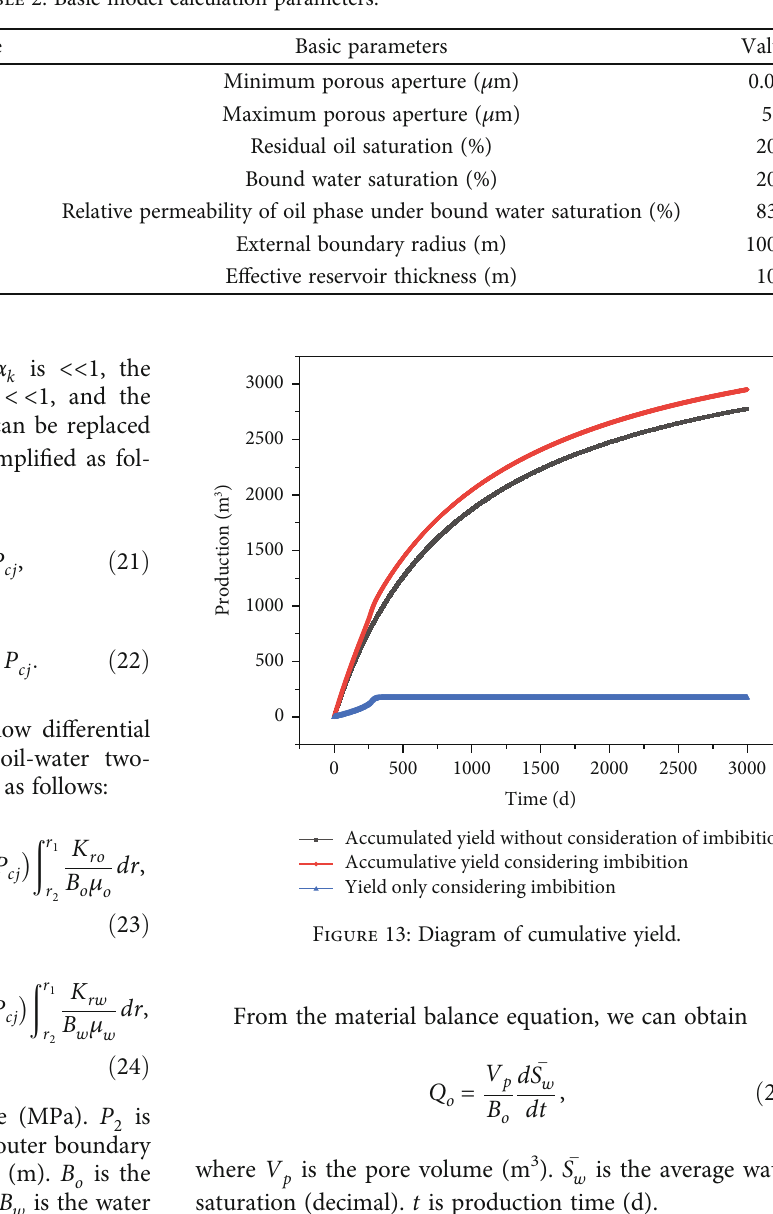
Table 2: Basic model calculation parameters.